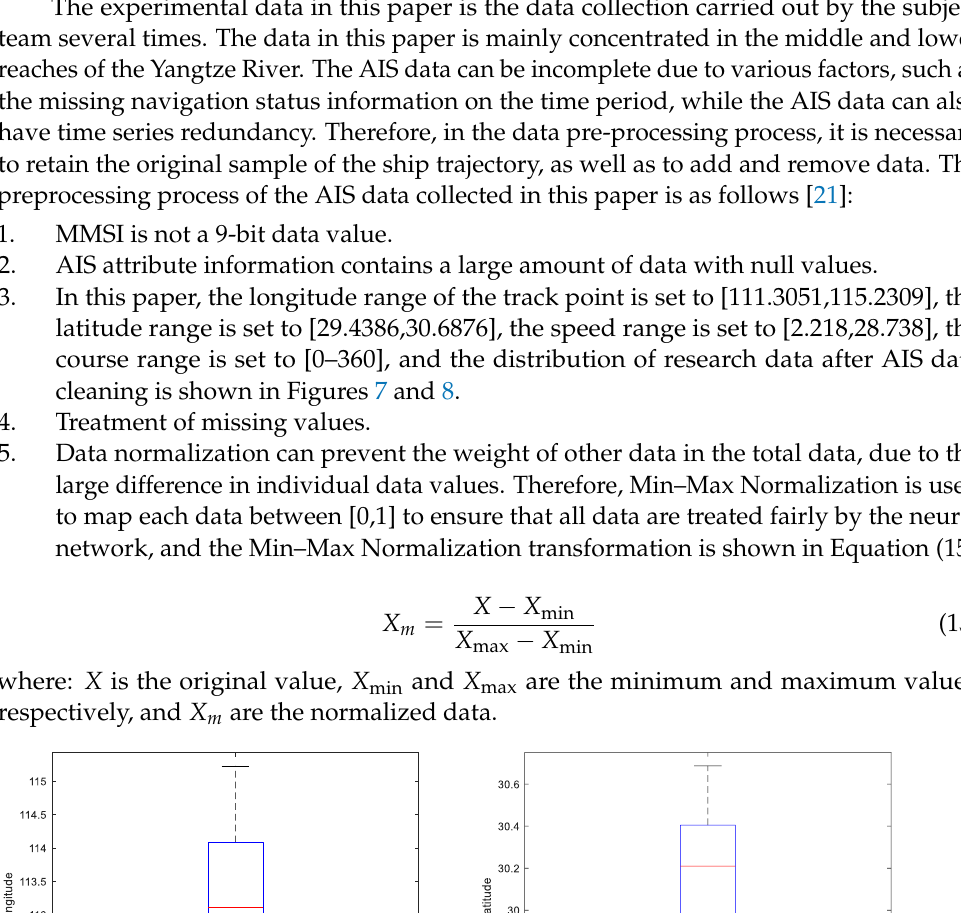
Figure 8. Distribution of speed and course.